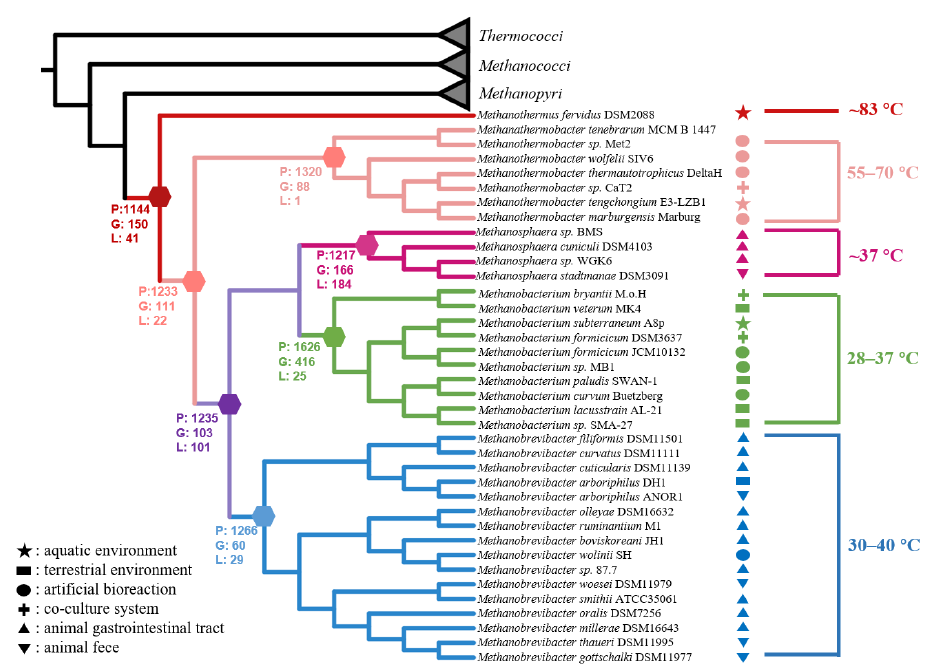
Figure 7. Phylogenomic tree of the class Methanobacteria , based on 37 marker protein sequences with the completely sequenced genomes of isolated strains from Thermococci , Methanococci , Mathanopyri , and Methanobacteria . We rooted the tree in the class Thermococci1 and labeled the optimum growth temperature ranges with corresponding colors as the genus within the class Methanobacteria . The number of present genes (P), gained genes (G), and lost genes (L) on the speculated common ancestor nodes were also labeled. The genus Methanothermus (83 ◦ C) is the deepest clade, followed by the genus Methanothermobacter (55–70 ◦ C). Other clades are the genera Methanobrevibacter (30–40 ◦ C), Methanosphaera (37 ◦ C), and Methanobacterium (28–37 ◦ C). We also labeled the in situ environments of strains with different geometries. The star denotes that the strains were isolated from natural aquatic environments, including hot springs or groundwater. The rectangle denotes that the strains were isolated from natural terrestrial environments, including permafrost, peat soil, and wet wood. The ellipse indicates that the strains were isolated from artificial bioreactions, including digesters and fermenters. The plus sign indicates that the strains were isolated from co-culture systems. The regular triangle indicates that the strains were isolated from gastrointestinal tracts of animals including mammals and termites. The del operator indicates that the strains were isolated from animal feces including those from mammals and